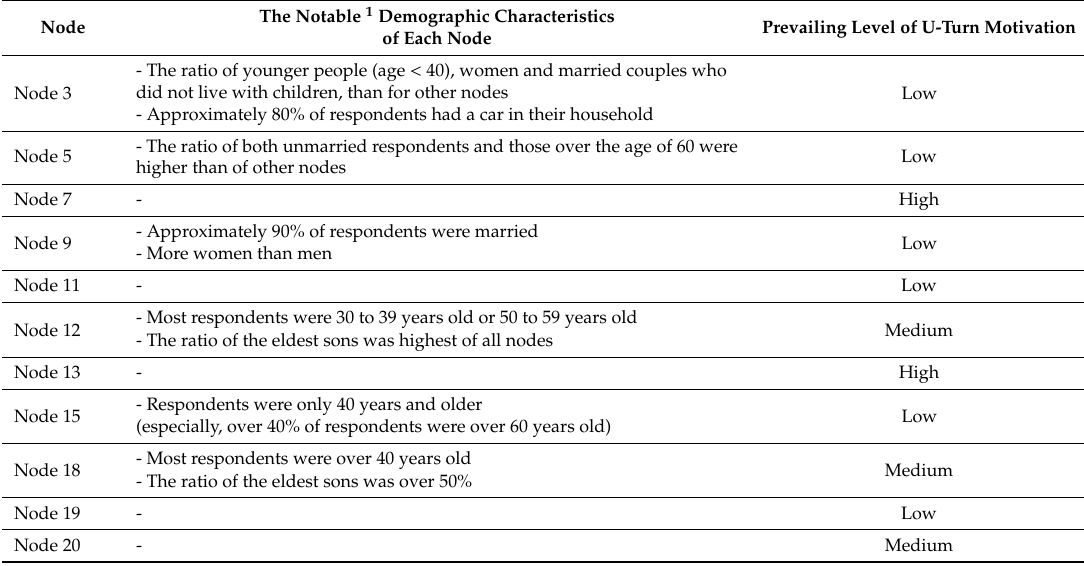
Table 7. The notable demographic characteristics of each